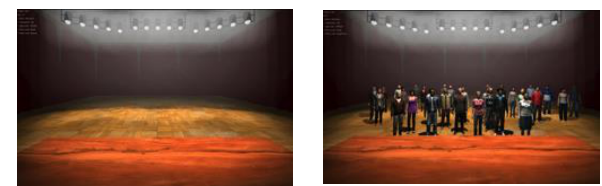
Figure 3. Example views of the conditions: empty room, engaged/disengaged audience.